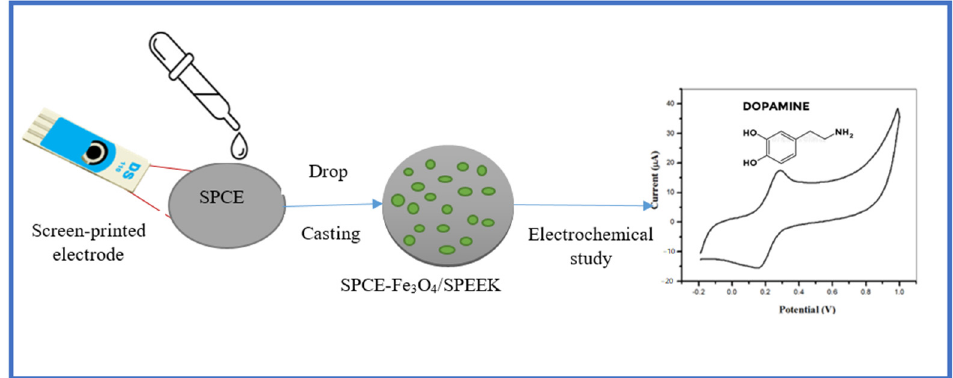
Figure 8. Schematic diagram of electrode modification procedure and the electrochemical response of dopamine at the electrode. of dopamine at the